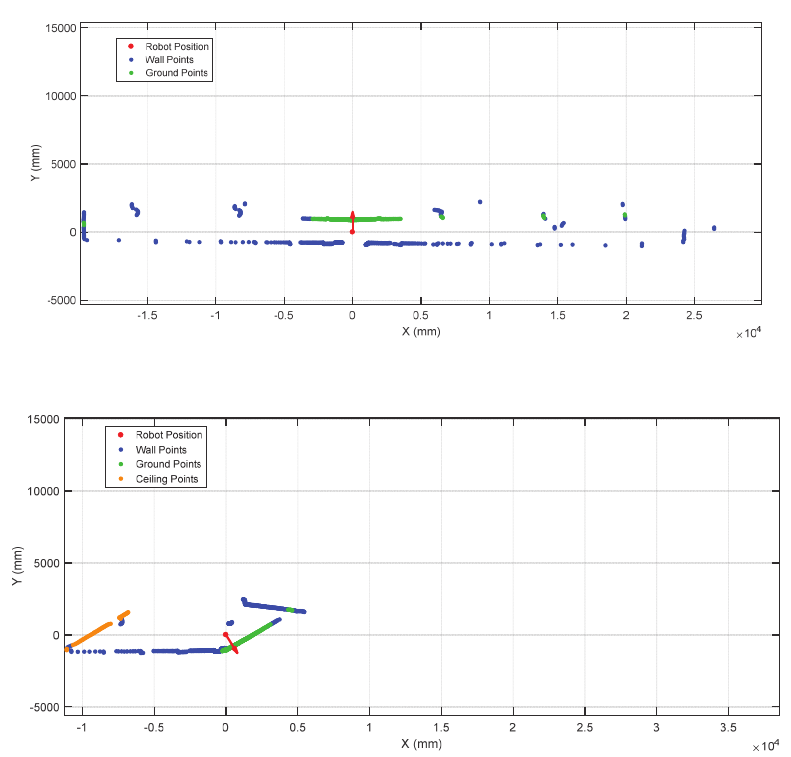
Figure 13. 2D projection of some scans gathered by the LIDAR placed at the starting positions shown in Figure 12: (top) right side of the corridor and (down) left side of the corridor.